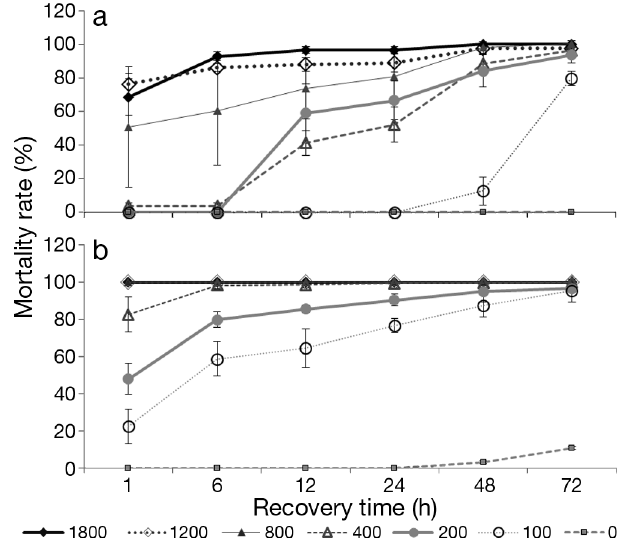
Fig. 1. Average mortality of (a) Capitella sp. and (b) Ophryo - trocha spp. at exposure concentrations (0, 100, 200, 400, 800, 1200, 1800 mg l − 1 , n = 3) of hydrogen peroxide. Error bars represent 1